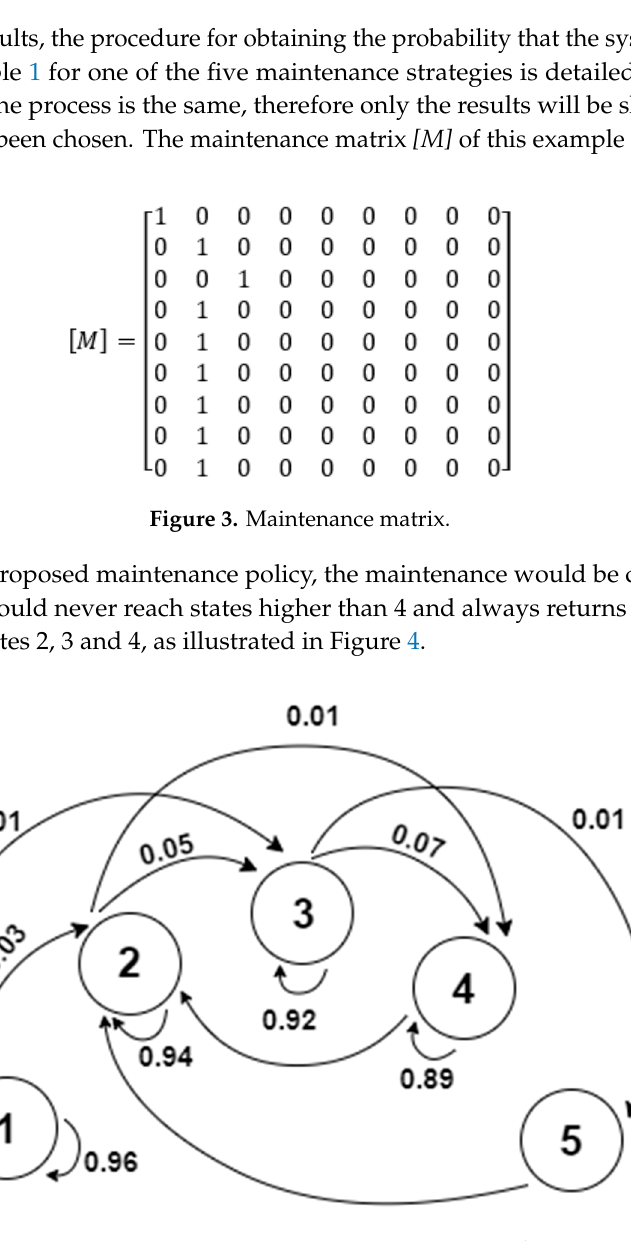
Figure 4. Maintenance strategy transition graph.